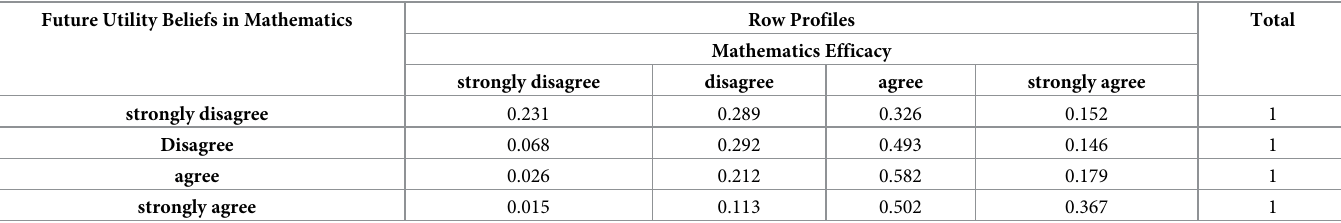
Table 2. Row profiles; for the variable Utility